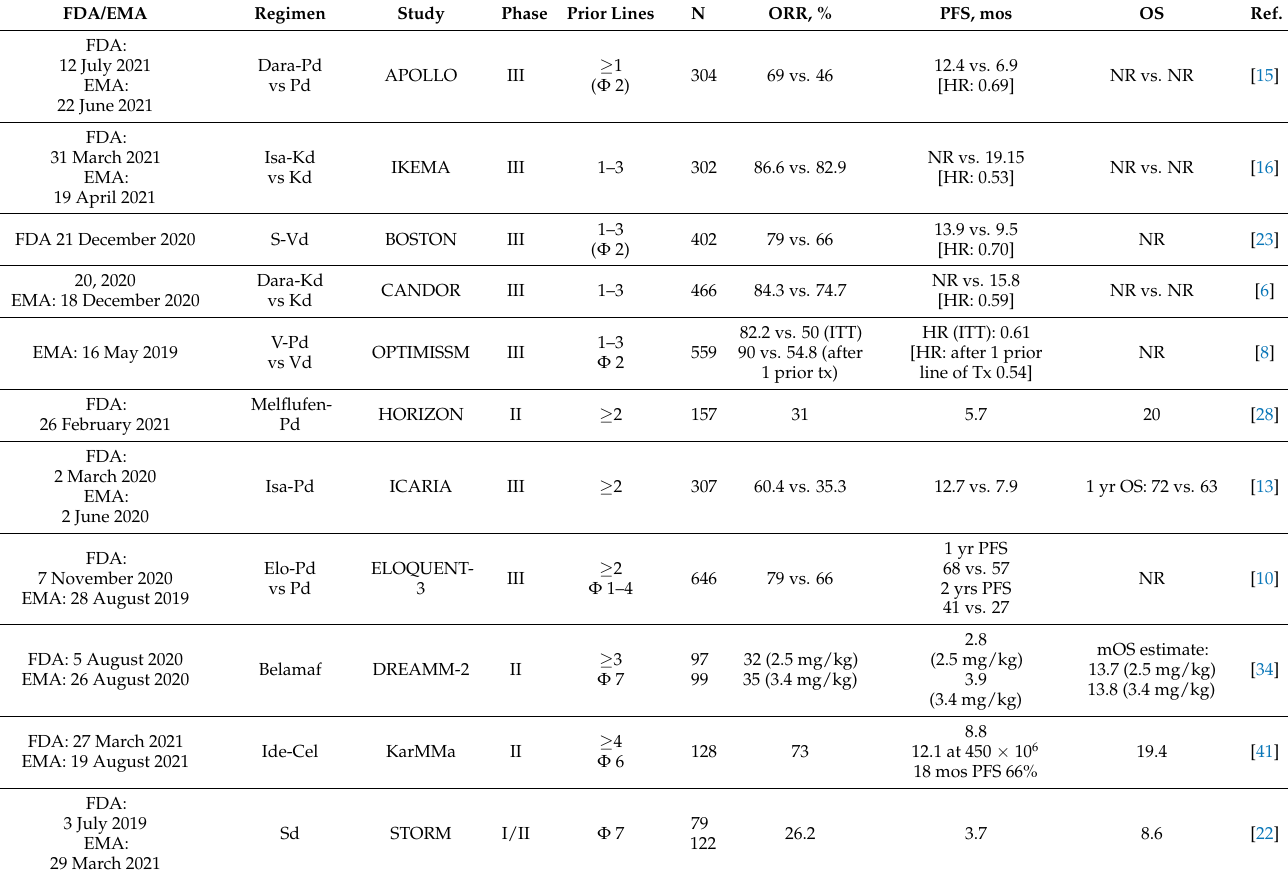
Table 1. Recent approvals for patients with relapsed/refractory multiple myeloma